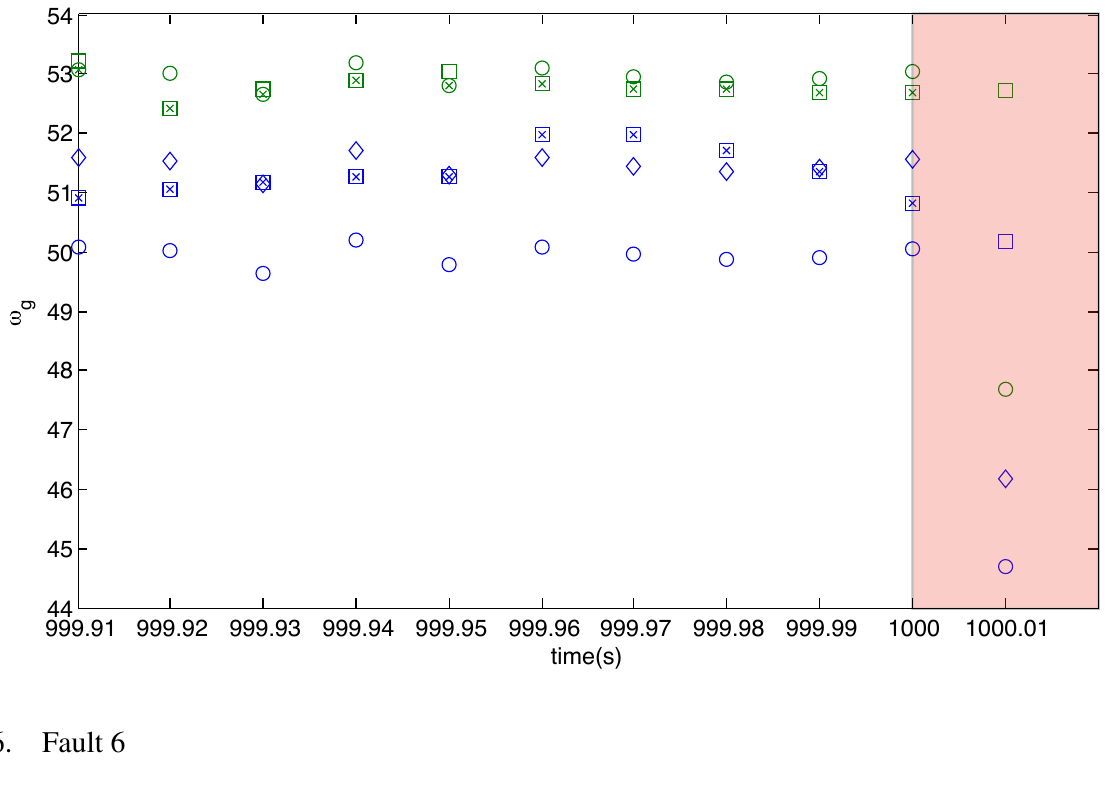
( k ) , ◦ : [ ω ( k )] y g , m 1 1